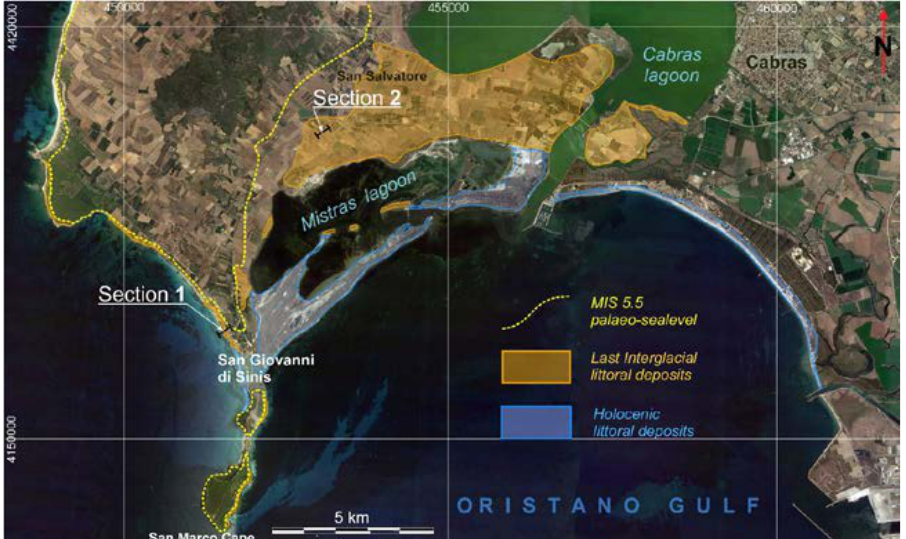
Figure 6. Aerial photograph of the coastal plain north of Oristano and the Sinis peninsula showing the main geomorphological features, yellow dashed line indicates the paleo high sea level of MIS 5.5; the littoral deposits of the last interglacial (LI) and the Holocenic shore deposits. Location of MIS 5 stratigraphic sections (Figure 7): Section 1 on the rocky coast of San Giovanni, Sinis peninsula; Section 2, on a Punic quarry located in the Cabras paleo-littoral barrier of MIS 5. The MIS 5.5 marine-littoral deposits sequence is most preserved along the western coast of San Giovanni di Sinis